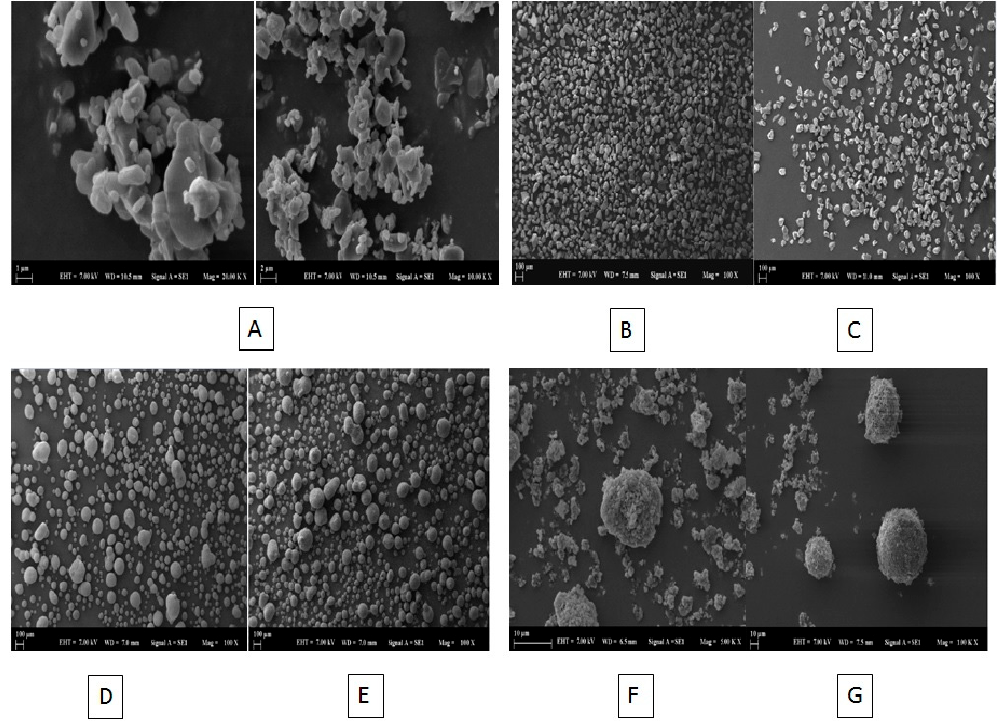
Figure 8. Scanning electron microscopy photographs of ( A ) Pure DFX, ( B ) Syloid XDP 3150, ( C ) P5-40-SYLOID, ( D ) Neusilin US2, ( E ) P5-40-US2, ( F ) Neusilin UFL2, and ( G ) P5-40-UFL2.